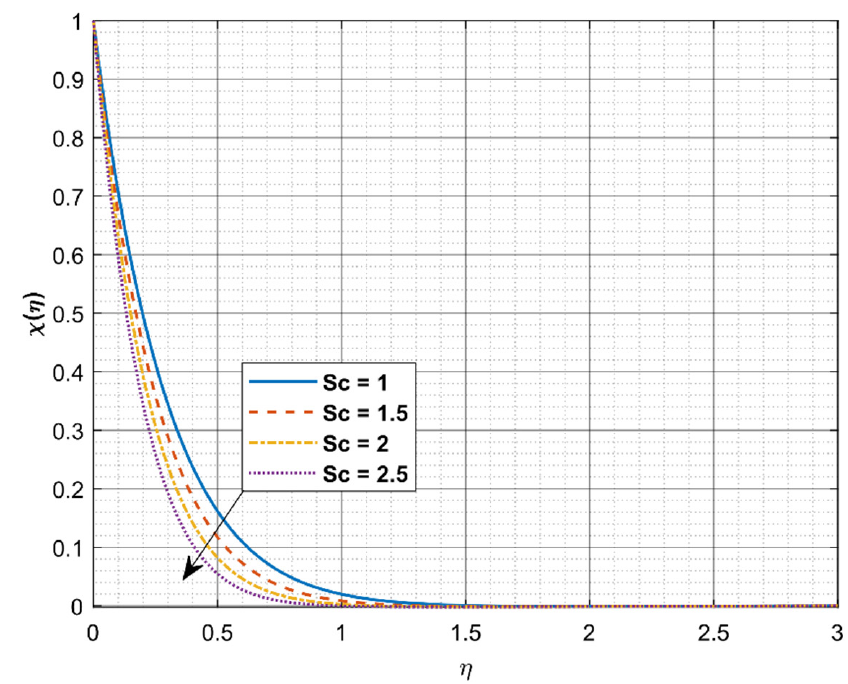
χη . Figure 10. Influence of Sc on χ ( η )